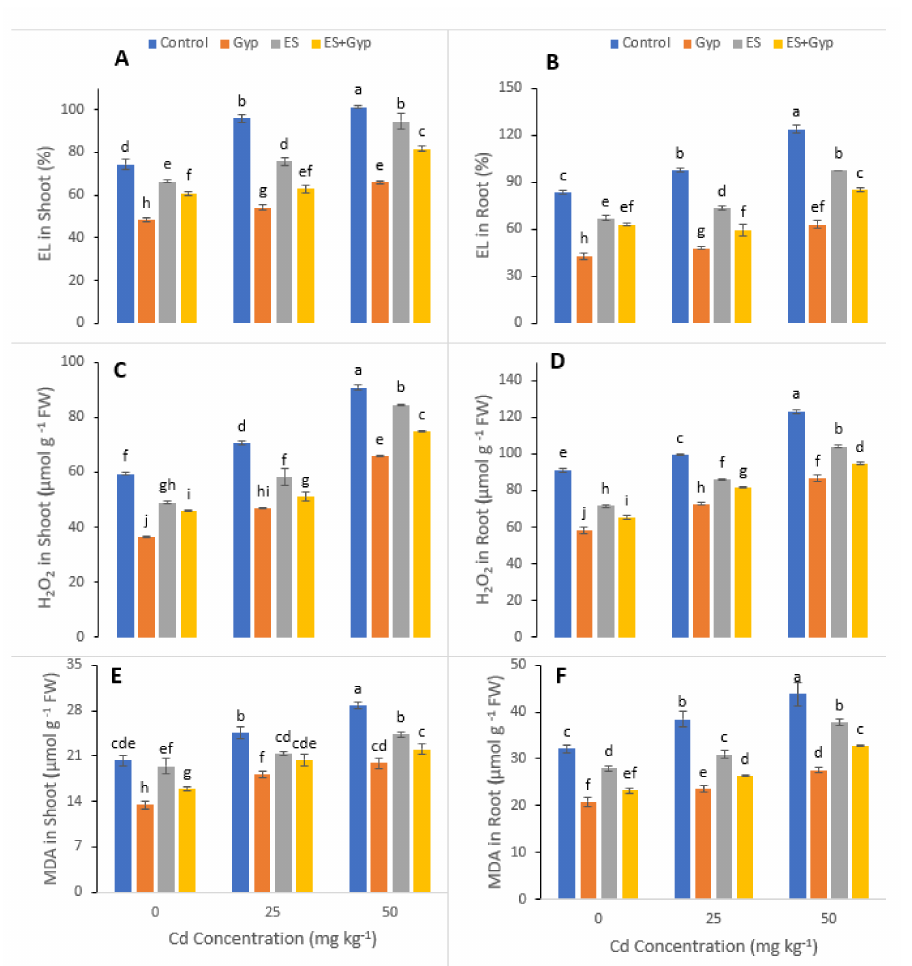
Figure 4. Effect of different concentrations of Cd (25, 50 mg kg − 1 ) in the soil on oxidative stress biomarkers i.e., electrolyte leakage in the shoots ( A ), electrolyte leakage in the roots ( B ), hydrogen peroxide content in the shoots ( C ), hydrogen peroxide content in the roots ( D ), malondialdehyde contents in the shoots ( E ) and malondialdehyde contents in the roots ( F ) of S. nigrum grown under the S-Fertilizers, alone with GYP, and ES and in combination GYP+ES . S-fertilizer showed significant increase in growth parameters compared to control. Bars sharing different letter(s) for each parameter are significantly different from each other according to Duncan’s multiple range test ( p < 0.05). All the data represented are the average of four